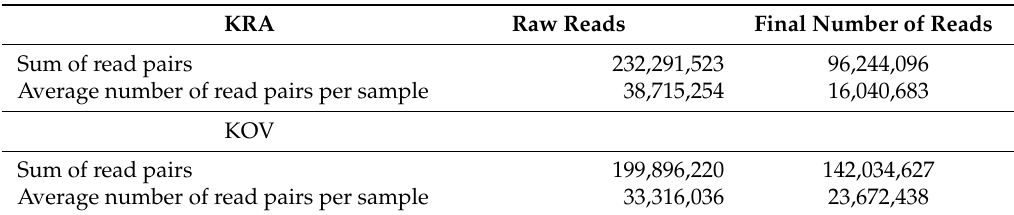
Table 1. Number of reads used for the construction of the KRA and KOV transcriptomes. Initial numbers of raw reads are compared with the final numbers after quality filtration and the removal of the reads derived from rRNA and organellar